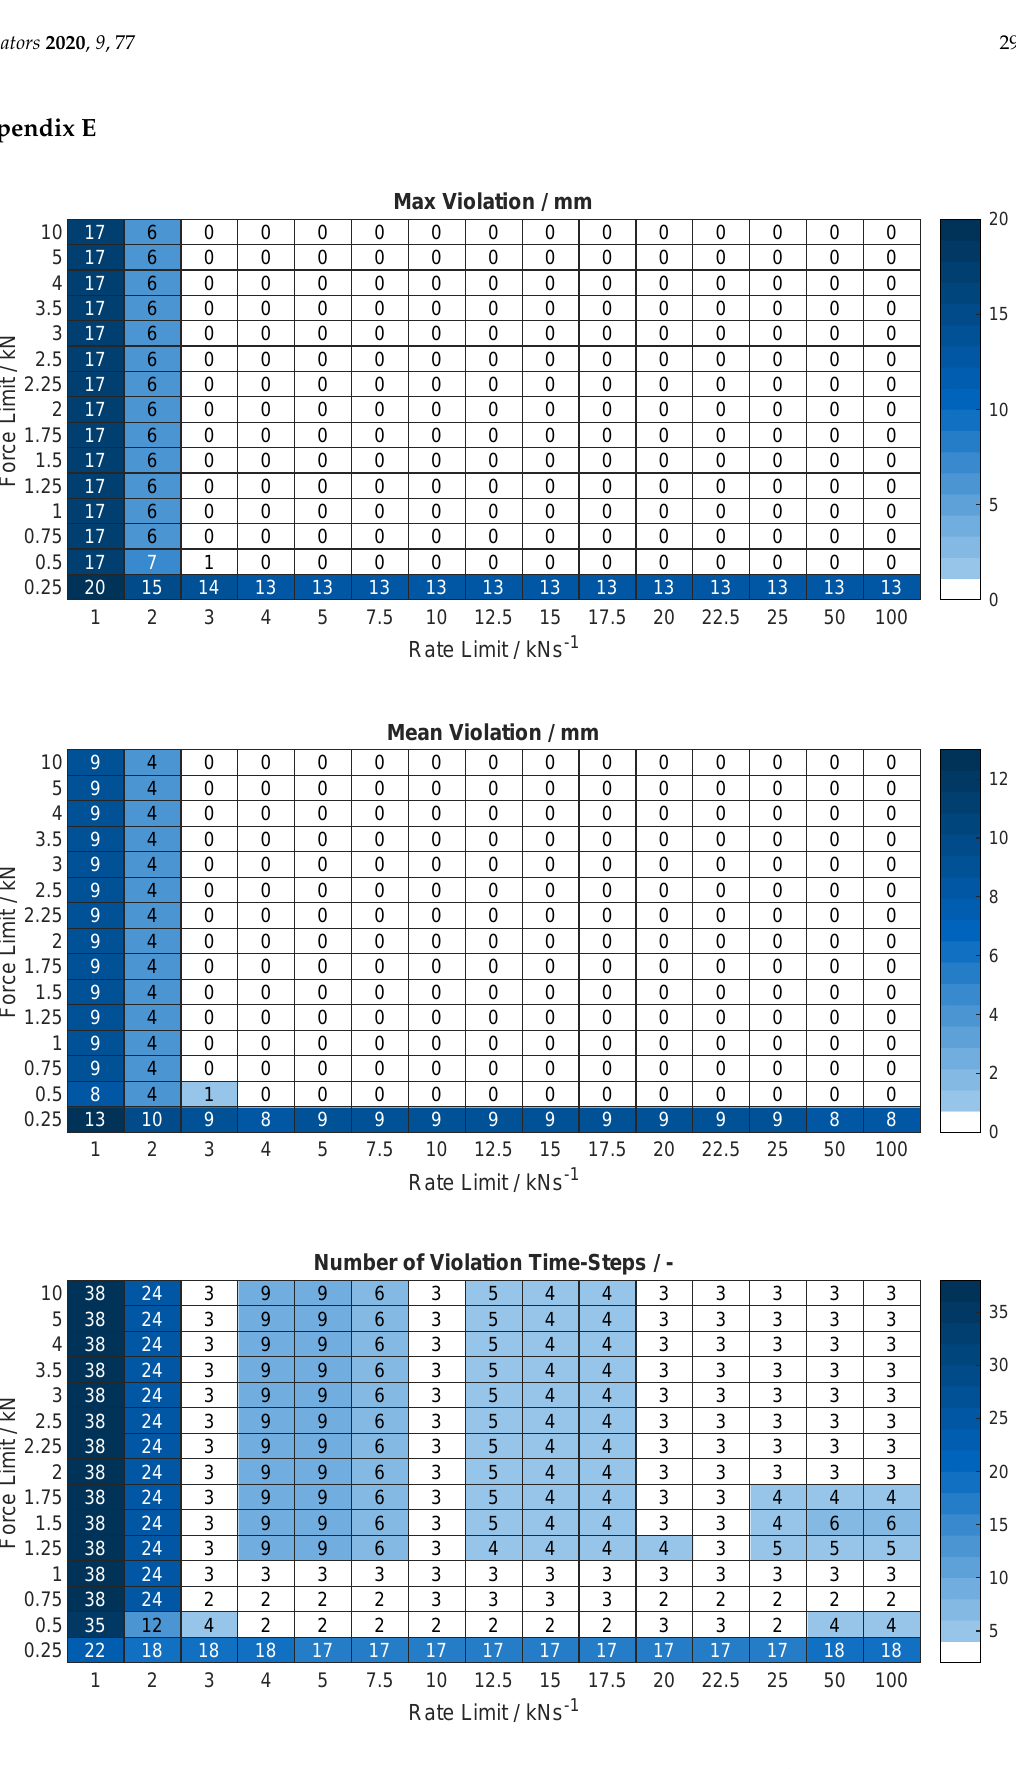
Figure A14. Suspension-deflection constraint violations in the 36kmh − 1 bump